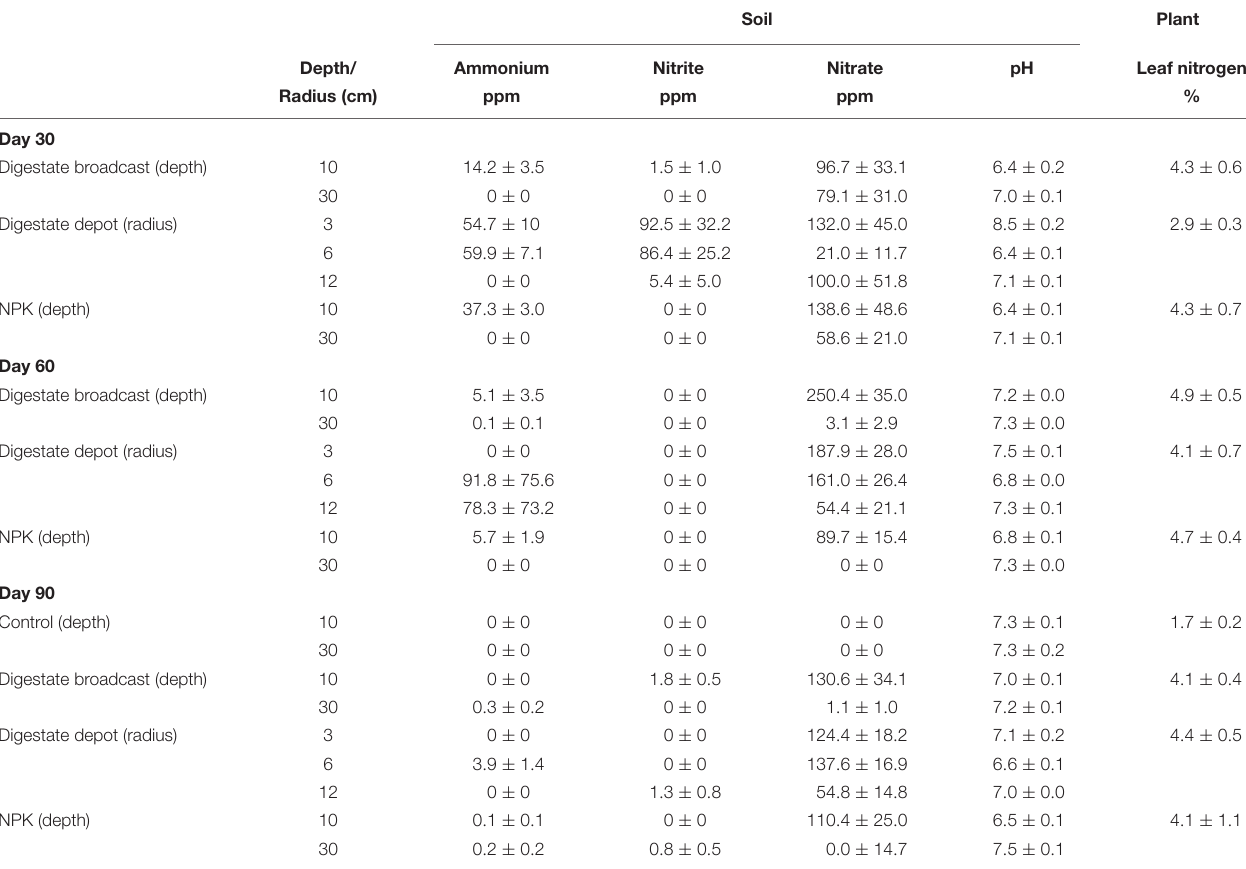
TABLE 2 | Soil and leaf analysis of S. hermaphrodita grown in rhizotrons.